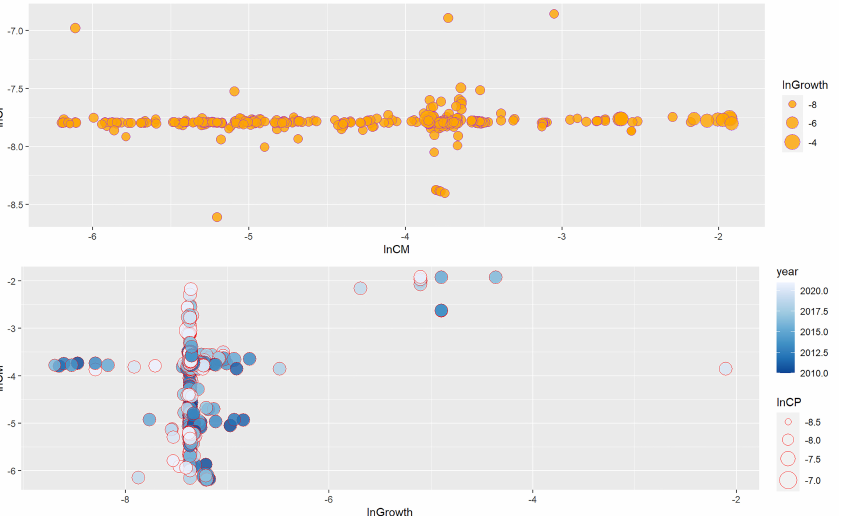
Figure 3. The scatter plot above (in orange) represents: the relationship between corporate manage- ment (lnCM) and corporate performance (lnCP); the scatter plot below (in purple) represents: the relationship between corporate management (lnCM) and growth capacity